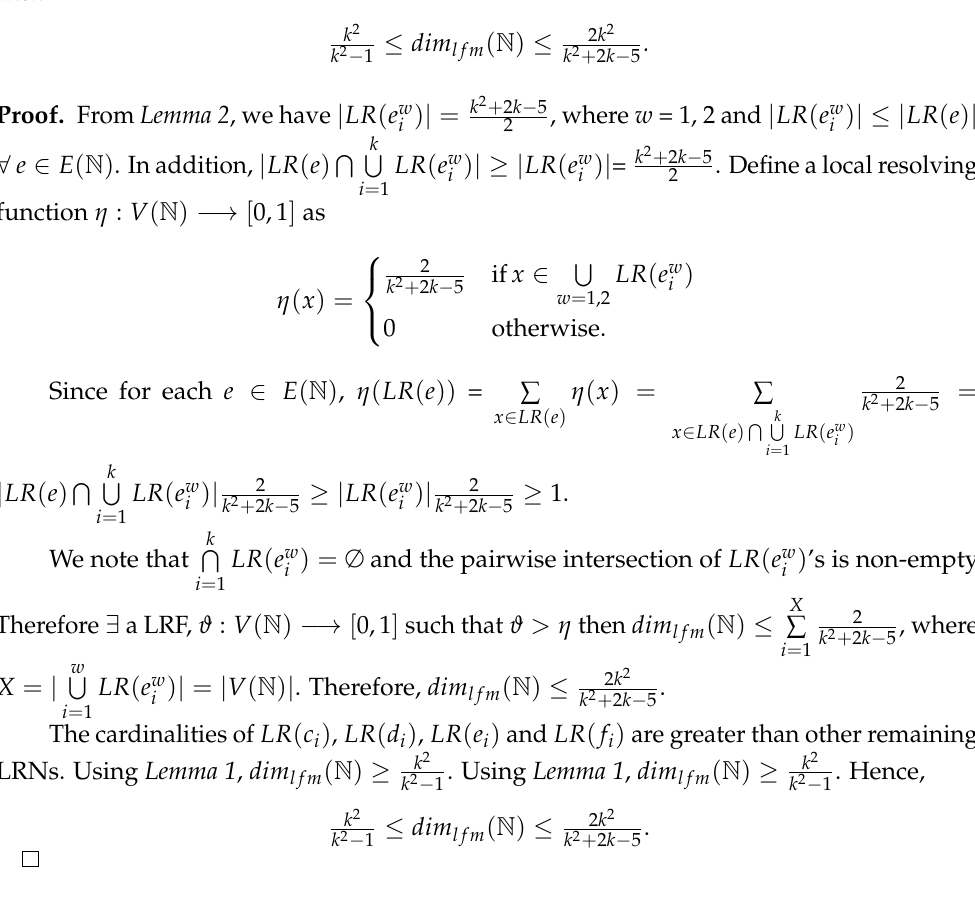
Table 4. Local resolving neighborhood set (LRNs) LR ( e y